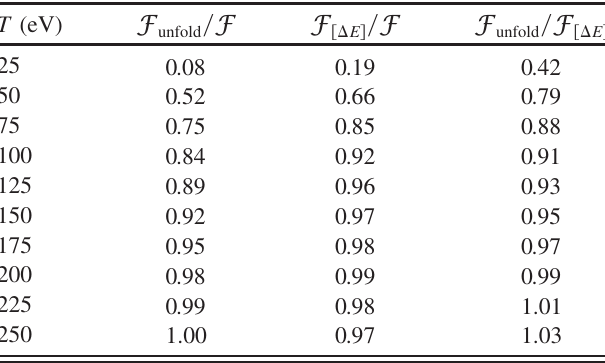
FIG. 10. Dependence of S ð T Þ , FIG. 9. Comparison of x-ray flux measures, F ð T Þ , F ½ on a non-negativity constraint. In Fig. 10(a), the solid (green) (cid:1) E (cid:7) ð T Þ ,forthePlanckiantestspectra S ð E; 25 eV (cid:2) T (cid:2) and F and dashed (black) curves represent reconstructed spectra that bb unfold 250 eV Þ above. Part (a) shows each measure on an absolute scale. have been consistently simulated and unfolded. The dotted (red) The dashed straight line associated with F ð T Þ is a least-squares, histogram was obtained when data are simulated and unfolded power-law fit that verifies T 4 scaling. (Other broken lines are inconsistently. Figure 10(b) shows the effect of applying a non- meant to guide the eye.) Part (b) shows flux-recovery ratios, negativity constraint to the simulation and unfold of F ð T Þ = F ð T Þ and F ð T Þ = F ð T Þ . For T (cid:9) 100 eV , ð E; 100 eV Þ in Fig. S ½ (cid:1) E (cid:7) unfold unfold bb F F within 20% (cf. Table IV). ð T Þ recovers F ½ (cid:1) E (cid:7) and unfold TABLE IV. Ratio of unfolded flux F to the two measures, unfold F and F ½ (cid:1) E (cid:7) of incident flux in a series of blackbody spectra, parametrized by temperature T . The simulations use response ; . . . ; R < 0 are included in functions R (Fig. 1). Values S j 1 5 F (cf. Table III and Sec. VI). unfold